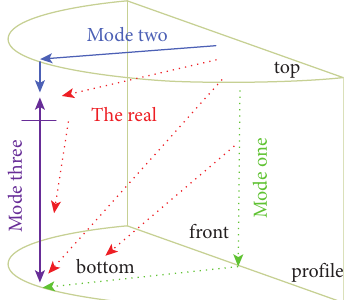
Figure 8: The path of split